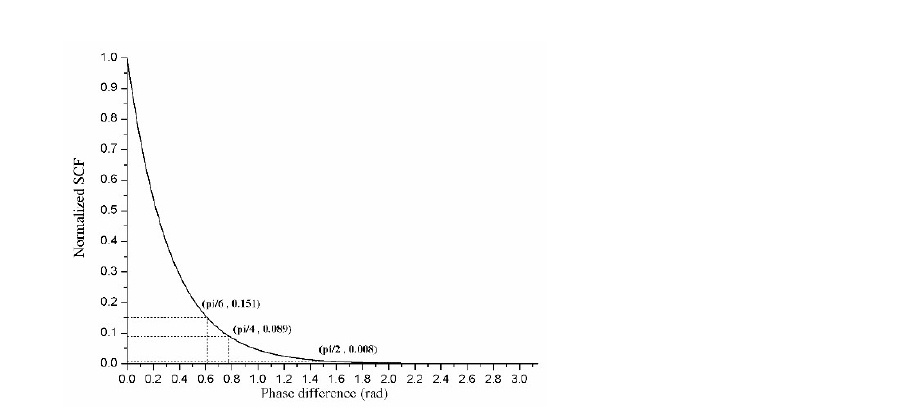
Figure 11. The curve of normalized SCF with respect to phase difference of two macro particles.